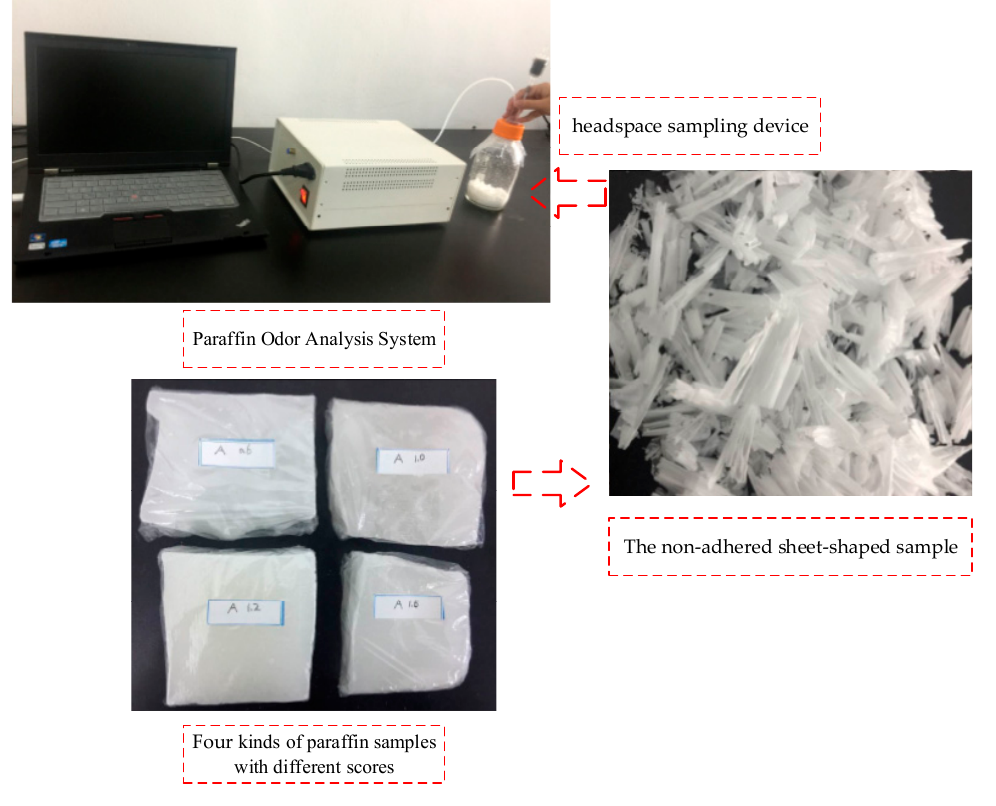
Figure 2. Paraffin odor analysis system.